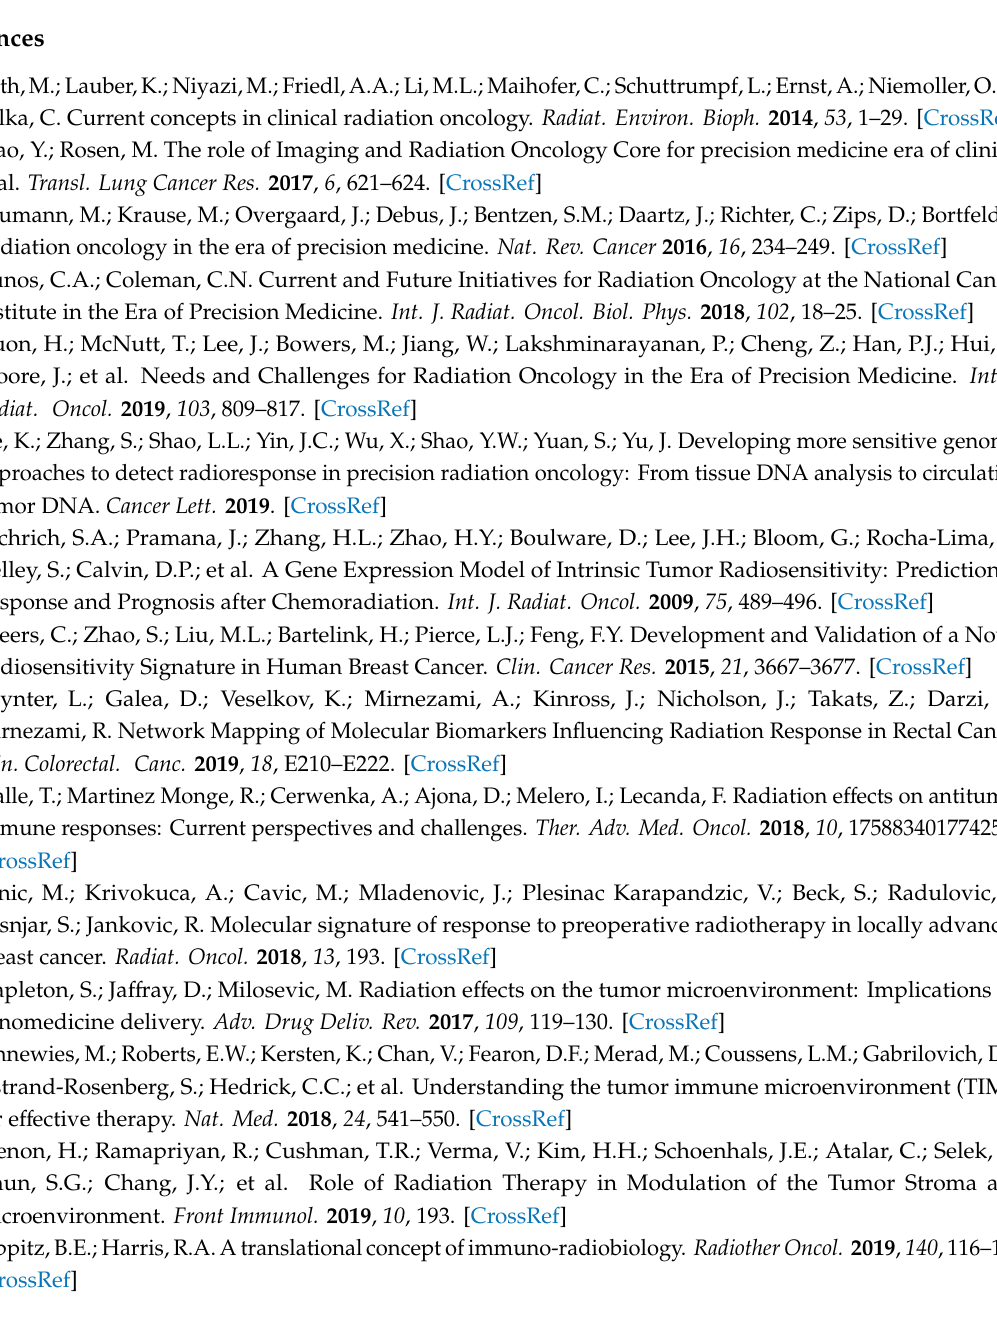
Table S1: Summary of the TCGA data, Table S2: Detailed information for the 7 cancers., Table S3: Description of the 3 predictable genes, Table S4: Univariable and multivariable cox regression analysis of 3-gene signature, Figure S1–S7: Correlation matrix for 7 cancer types, Figure S8: DEGs between high immune level group and low immune